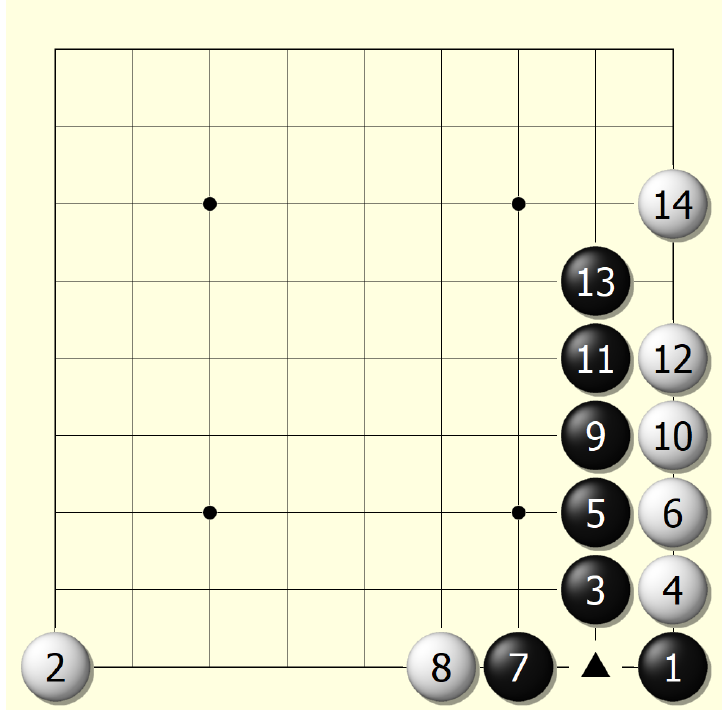
Figure 8. A typical situation where the white falls behind. Starting from Step 4, white tried hard to prevent black from using the triangle strategy, but black always took the lead. Although white made a wise choice in Step 14 and terminated the ‘chasing game’, black successfully built a triangle structure in Step 7. The whole process indicates that black has an obvious advantage over white when the NoGoZero+ agent is